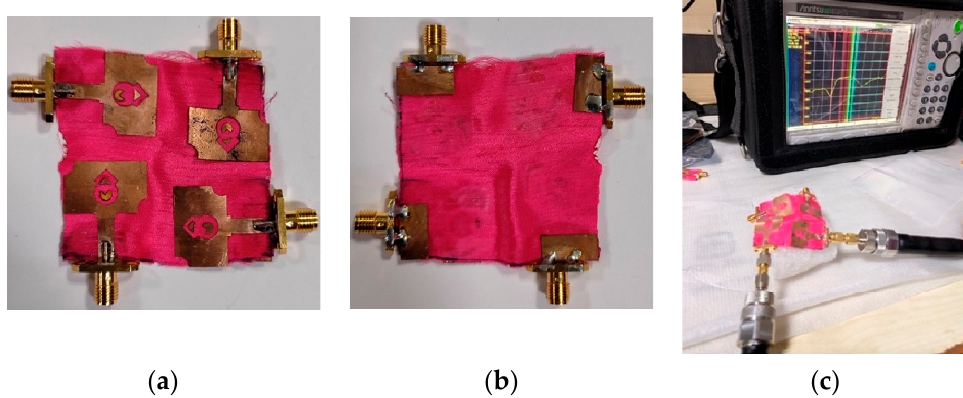
Figure 9. Fabricated MIMO antenna: ( a ) front side, ( b ) back side, ( c ) antenna measurement using VNA.